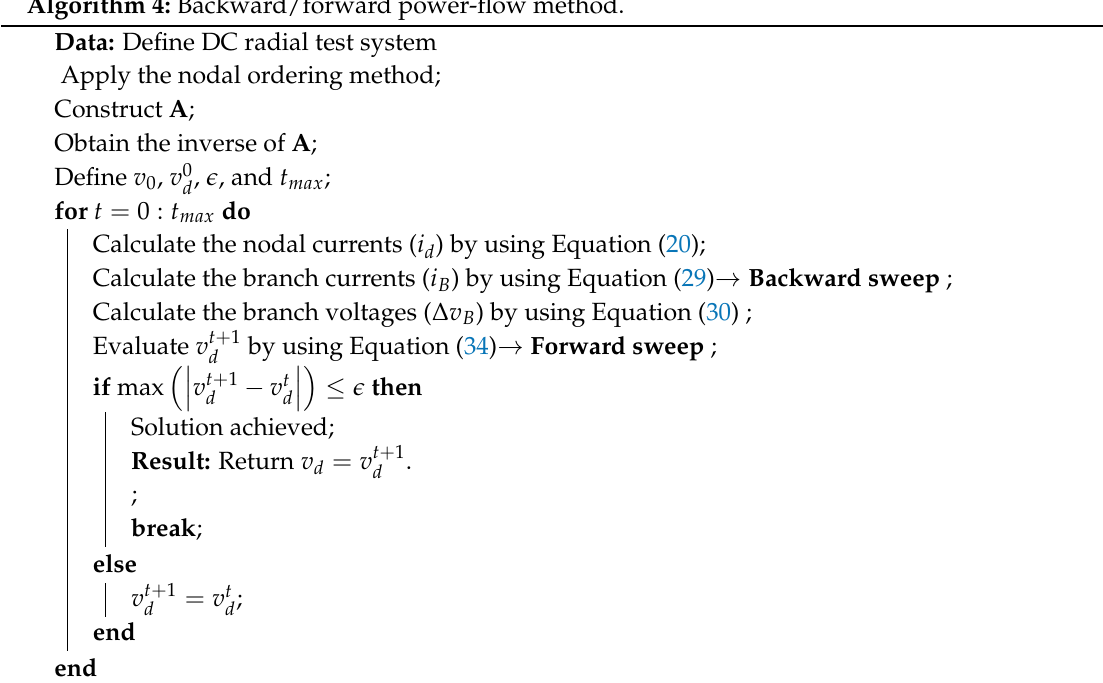
Algorithm 4: Backward/forward power-flow method. Data: Define DC radial test system